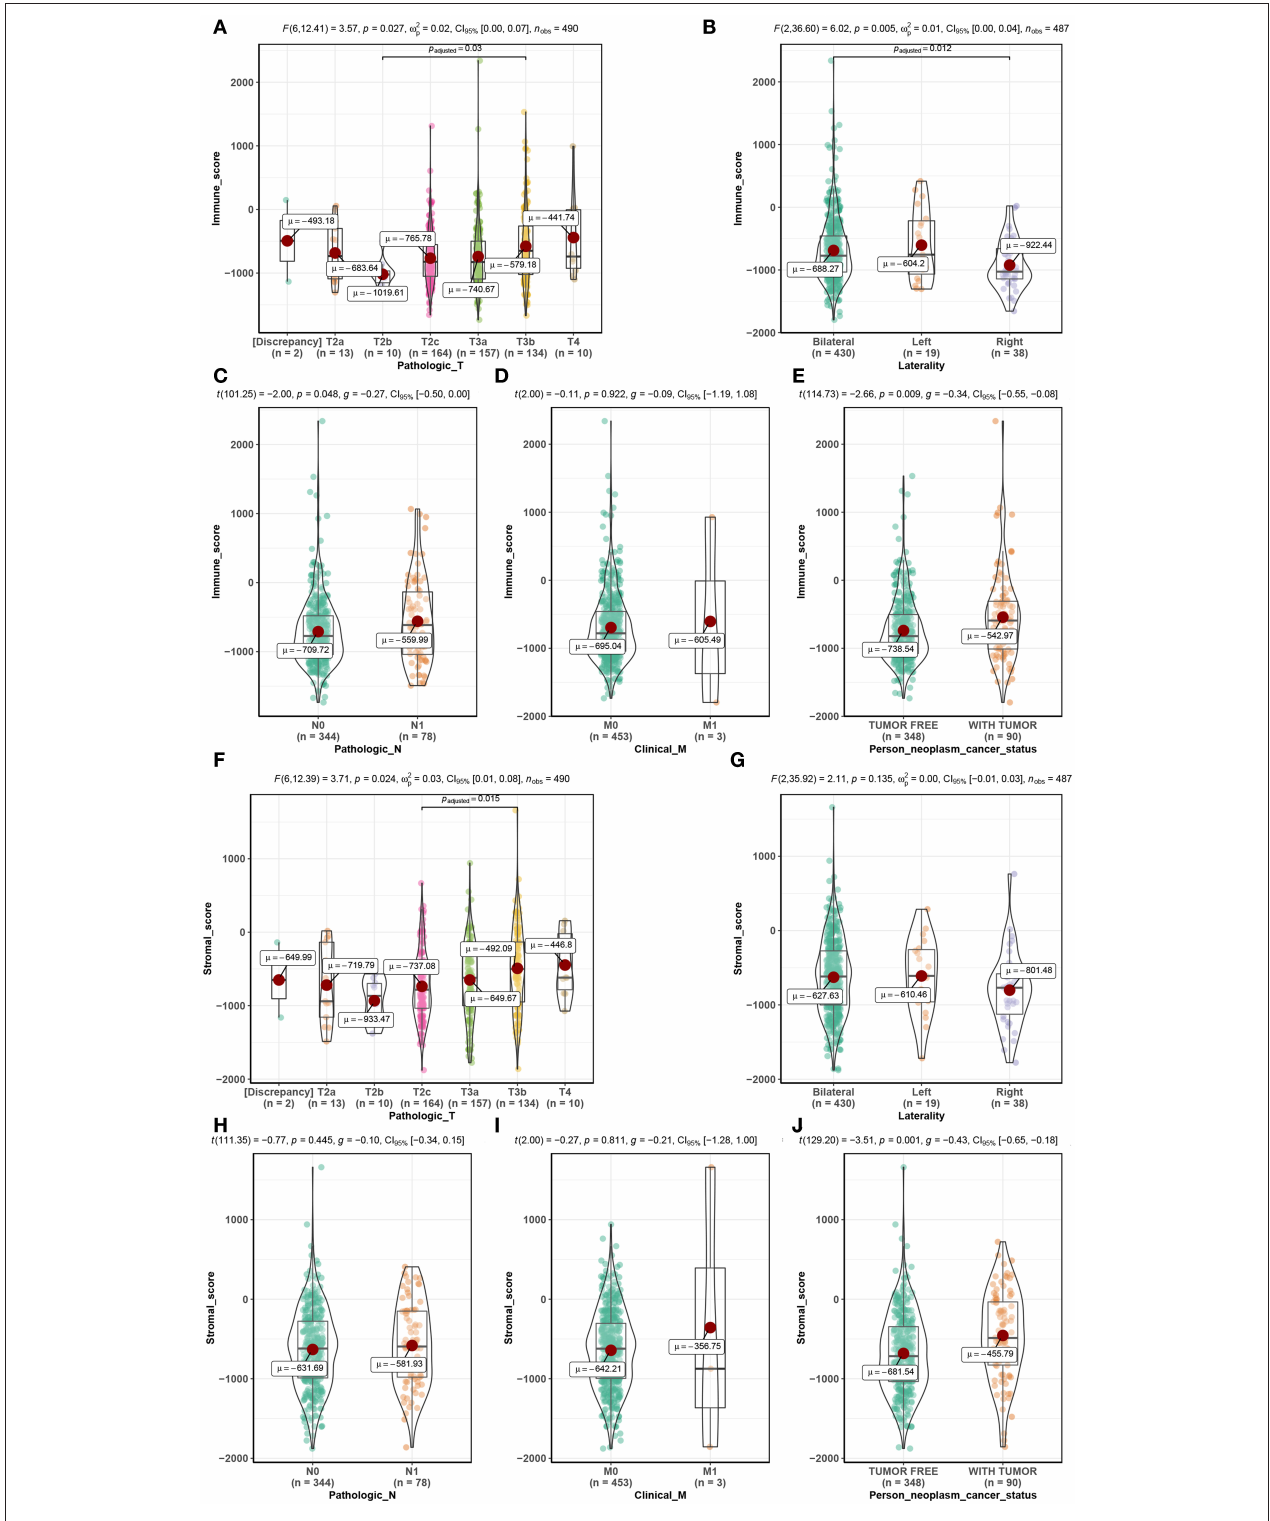
FIGURE 2 | Distribution of immune scores of pathologic T (A) , laterality (B) , pathologic N (C) , clinical M (D) , and person neoplasm cancer status (E) . Distribution of stromal scores of pathologic T (F) , laterality (G) , pathologic N (H) , clinical M (I) , and person neoplasm cancer status (J) .